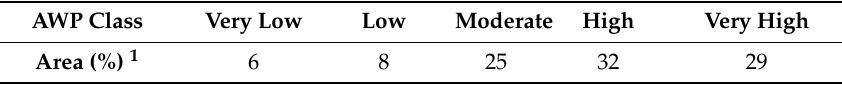
Table 7. Areas (%) of the five AWP categories in the West Bank case study.